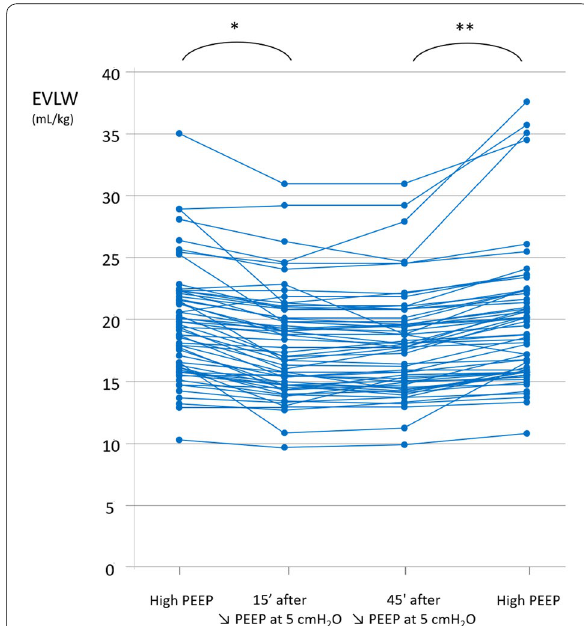
Fig. 1 Individual values of extravascular lung water (EVLW) at different study times. PEEP positive end‑expiratory pressure. * p < 0.05